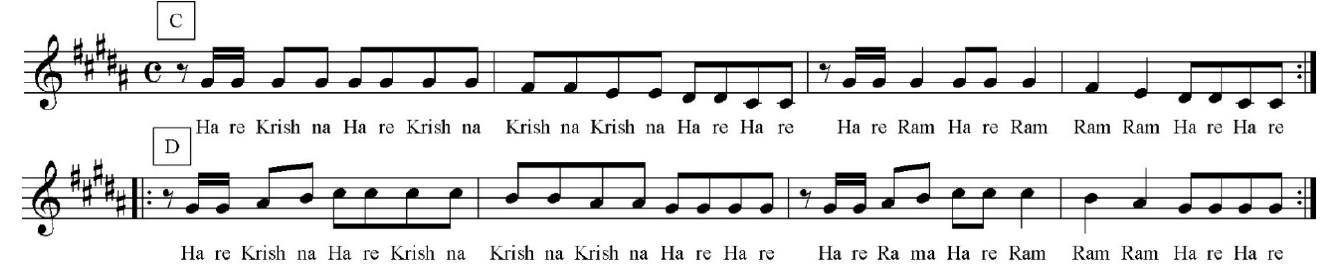
Figure 8. Melodies C and D.